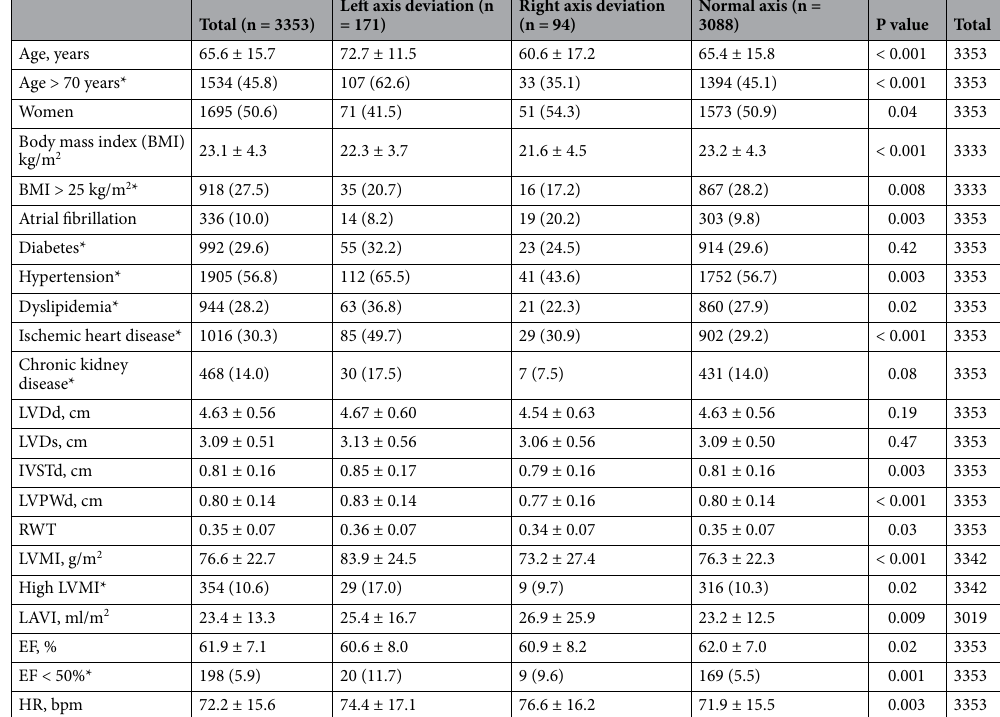
Table 1. Baseline characteristics of the study subjects and transthoracic echocardiography results of the patients. Values are number (%), mean ± SD. BMI body mass index, EF ejection fraction, HR heart rate, IVSTd diastolic interventricular septal wall thickness, LAVI left atrial volume index, LVDd left ventricular diastolic dimension, LVDs left ventricular systolic dimension, LVMI left ventricular mass index, LVPWd diastolic left ventricular posterior wall thickness, RWT relative wall thickness. P values were calculated using the chi square test or Fisher’s exact test for categorical variables, and the one-way analysis of variance (ANOVA) test for continuous variables. *Potential risk-adjusting variables selected for cox proportional hazard